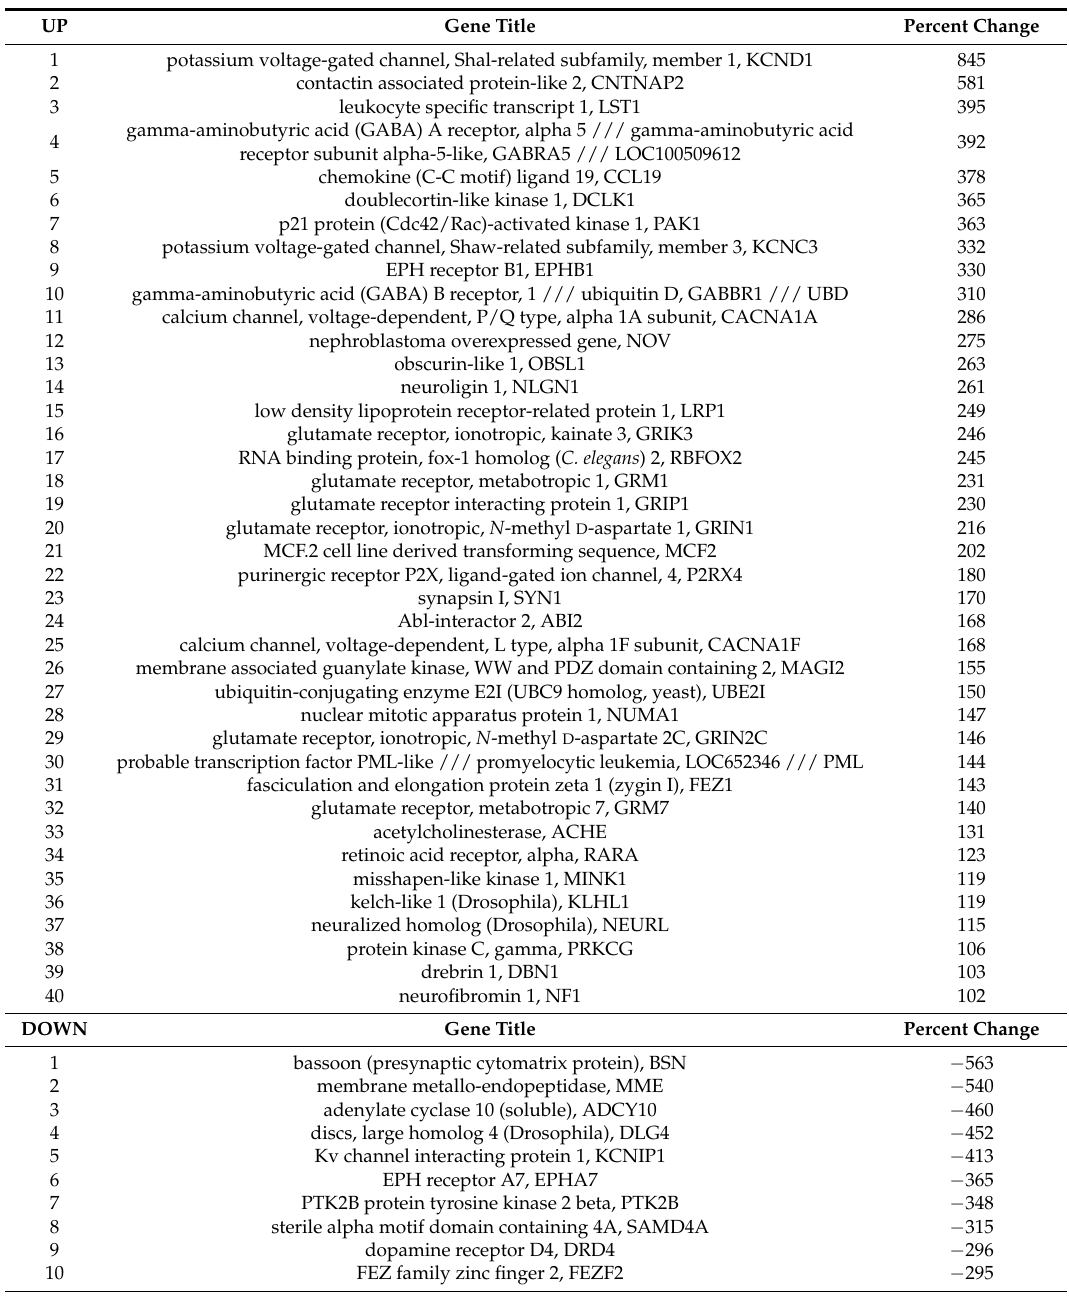
Table 24. GHK and Genes Associated with